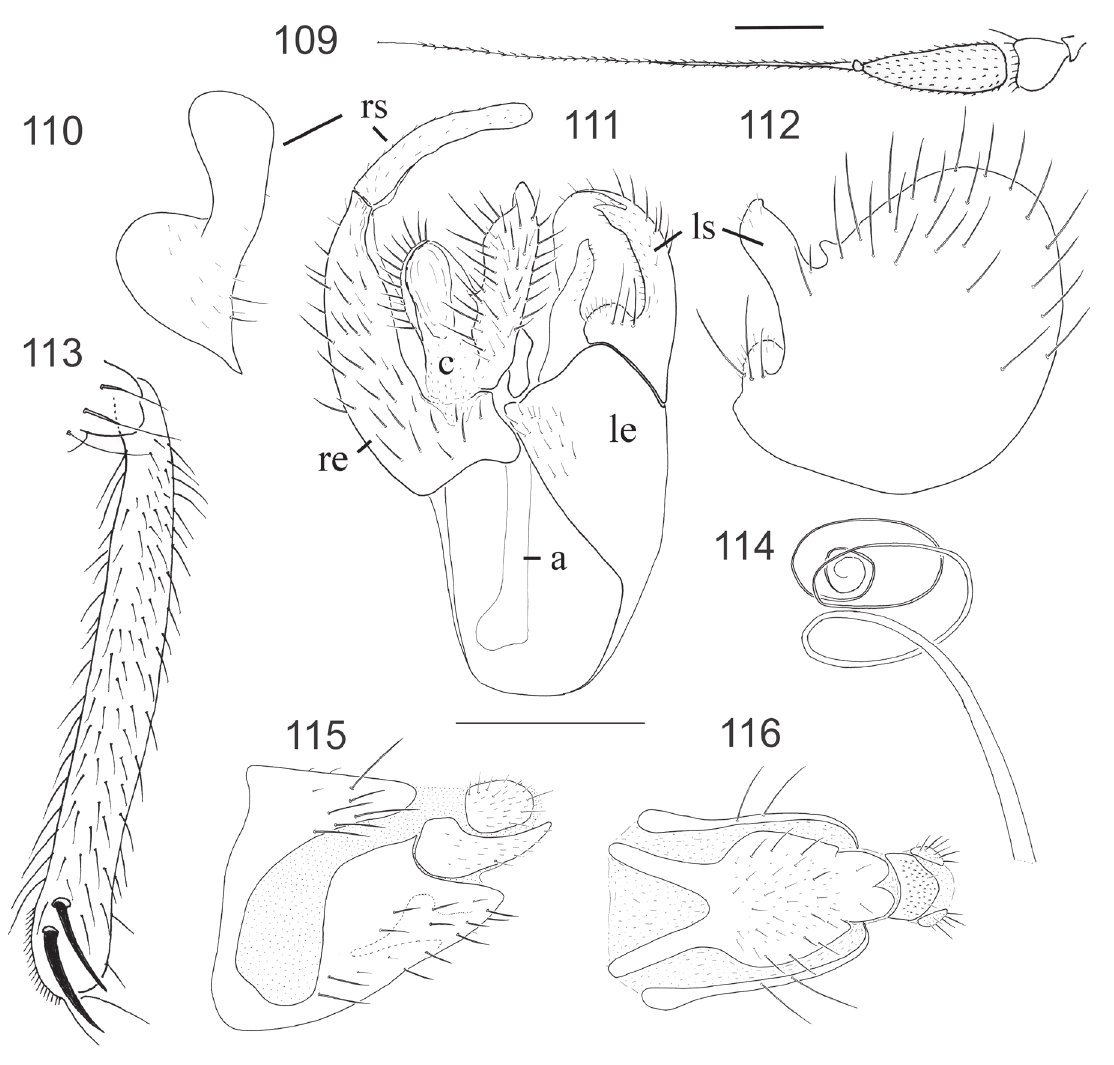
Figs 109-116. Elaphropeza biuncinata (Melander, 1928). 109 . antenna, ♂, lateral view. 110-114 . ♂ terminalia. 110 . right surstylus, dorsal view. 111 . epandrium and cerci, dorsal view. 112 . left surstylus, lateral view. 113 . hind tibia, male, posterior view; 114 . phallus. 115 . female ovipositor, lateral view; 116 . female ovipositor, ventral view. Scale bar = 0.1 mm (after Shamshev & Grootaert